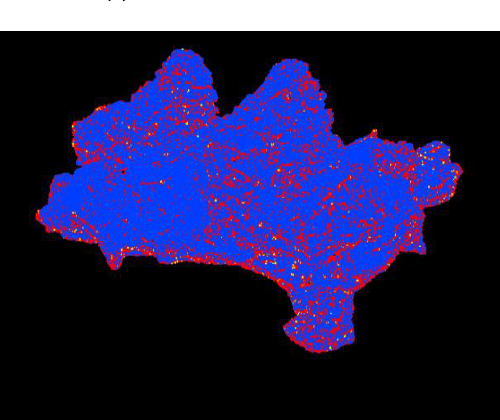
(more than 0.09mm) cluster to some parts, while error distribution of other part have no eminent tendency. This means this qualification method can access local matching quality in a point